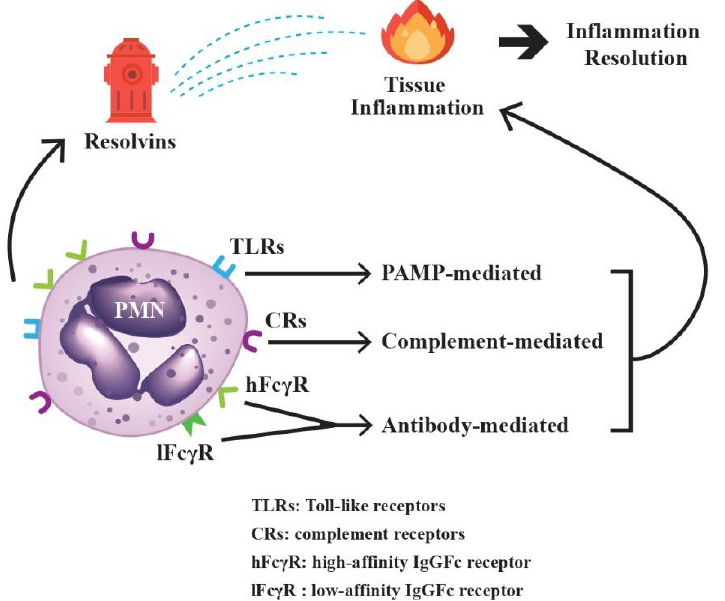
Figure 2. The paradoxical activities of PMNs on tissue inflammation and inflammation resolution. The surface-expressed Toll-like receptors (TLRs) bind to pathogen-associated molecular patterns (PAMPs), complement receptors (CRs) bind to antigen-antibody-complement immune complexes, and high-affinity (hFcγR) and low-affinity IgG Fc receptors (lFcγR) bind to IgG antibodies, which then can induce tissue inflammation. On the other hand, resolvins, the metabolic products of omega-3 polyunsaturated fatty acid synthesized during the initial phases of acute inflammatory responses, can promote the resolution of inflammation. Both inflammation and its resolution can be mediated by PMNs for immune homeostasis.